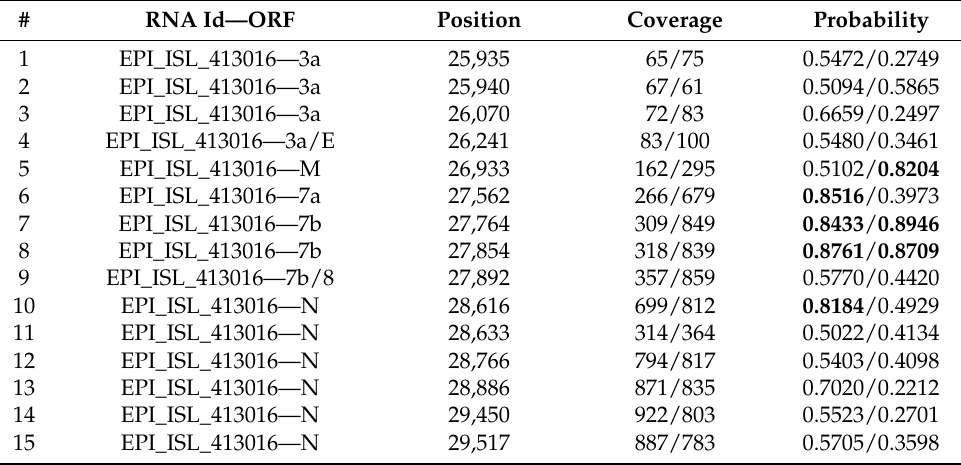
Table 1. Distribution and sequencing coverage of potential methylated adenosines in SARS-CoV-2 RNA genome. Coverage > 100 × is underlined and probability > 80 is in boldface as calculated by m6Anet [34]. After m6Anet analysis, only sites with coverage above 60 were considered. Position numbering according to Wuhan reference sequence (GenBank NC_045512). In Coverage and Proba- bility columns, the results for two technical replicates are shown. The first numbers on these columns represent the experiment shown in Figure